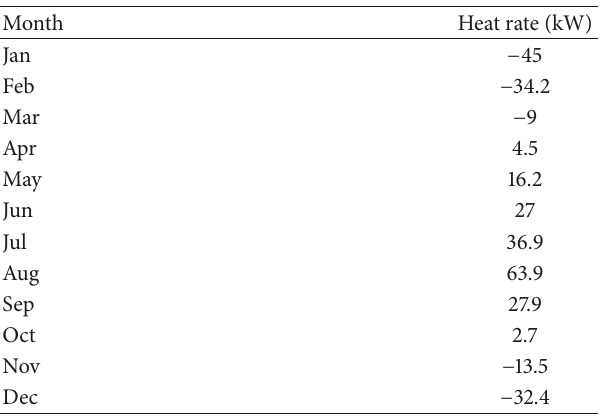
Table 3: Monthly average heat extraction/rejection rates.